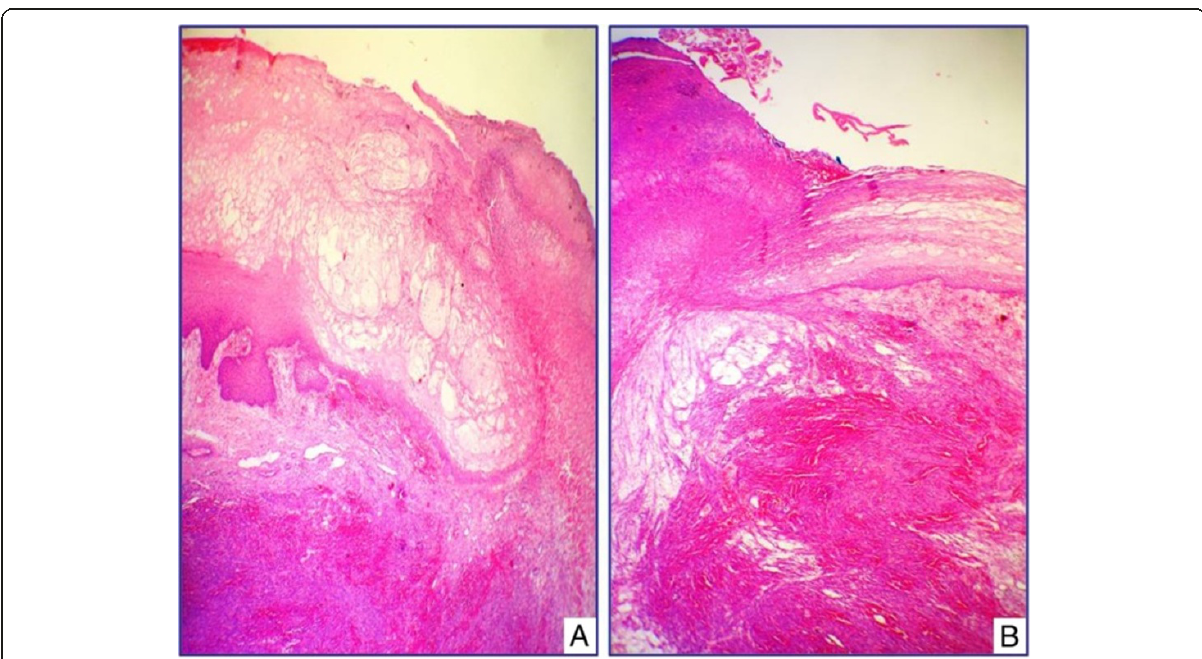
Figure 4 Microscopic appearances of a bullous KS: intraepidermal bulla structure and serum exudation are observed within squamous epithelium of a nodular stage KS (A-B; H&E, A, X50, B, X100). Nuclear immunoreaction with HHV-8 ( LNA-1) is observed in a tumor tissue composed of extravasated erythrocytes and spindle cells (C; H&E, X400, D; ABC-DAB,